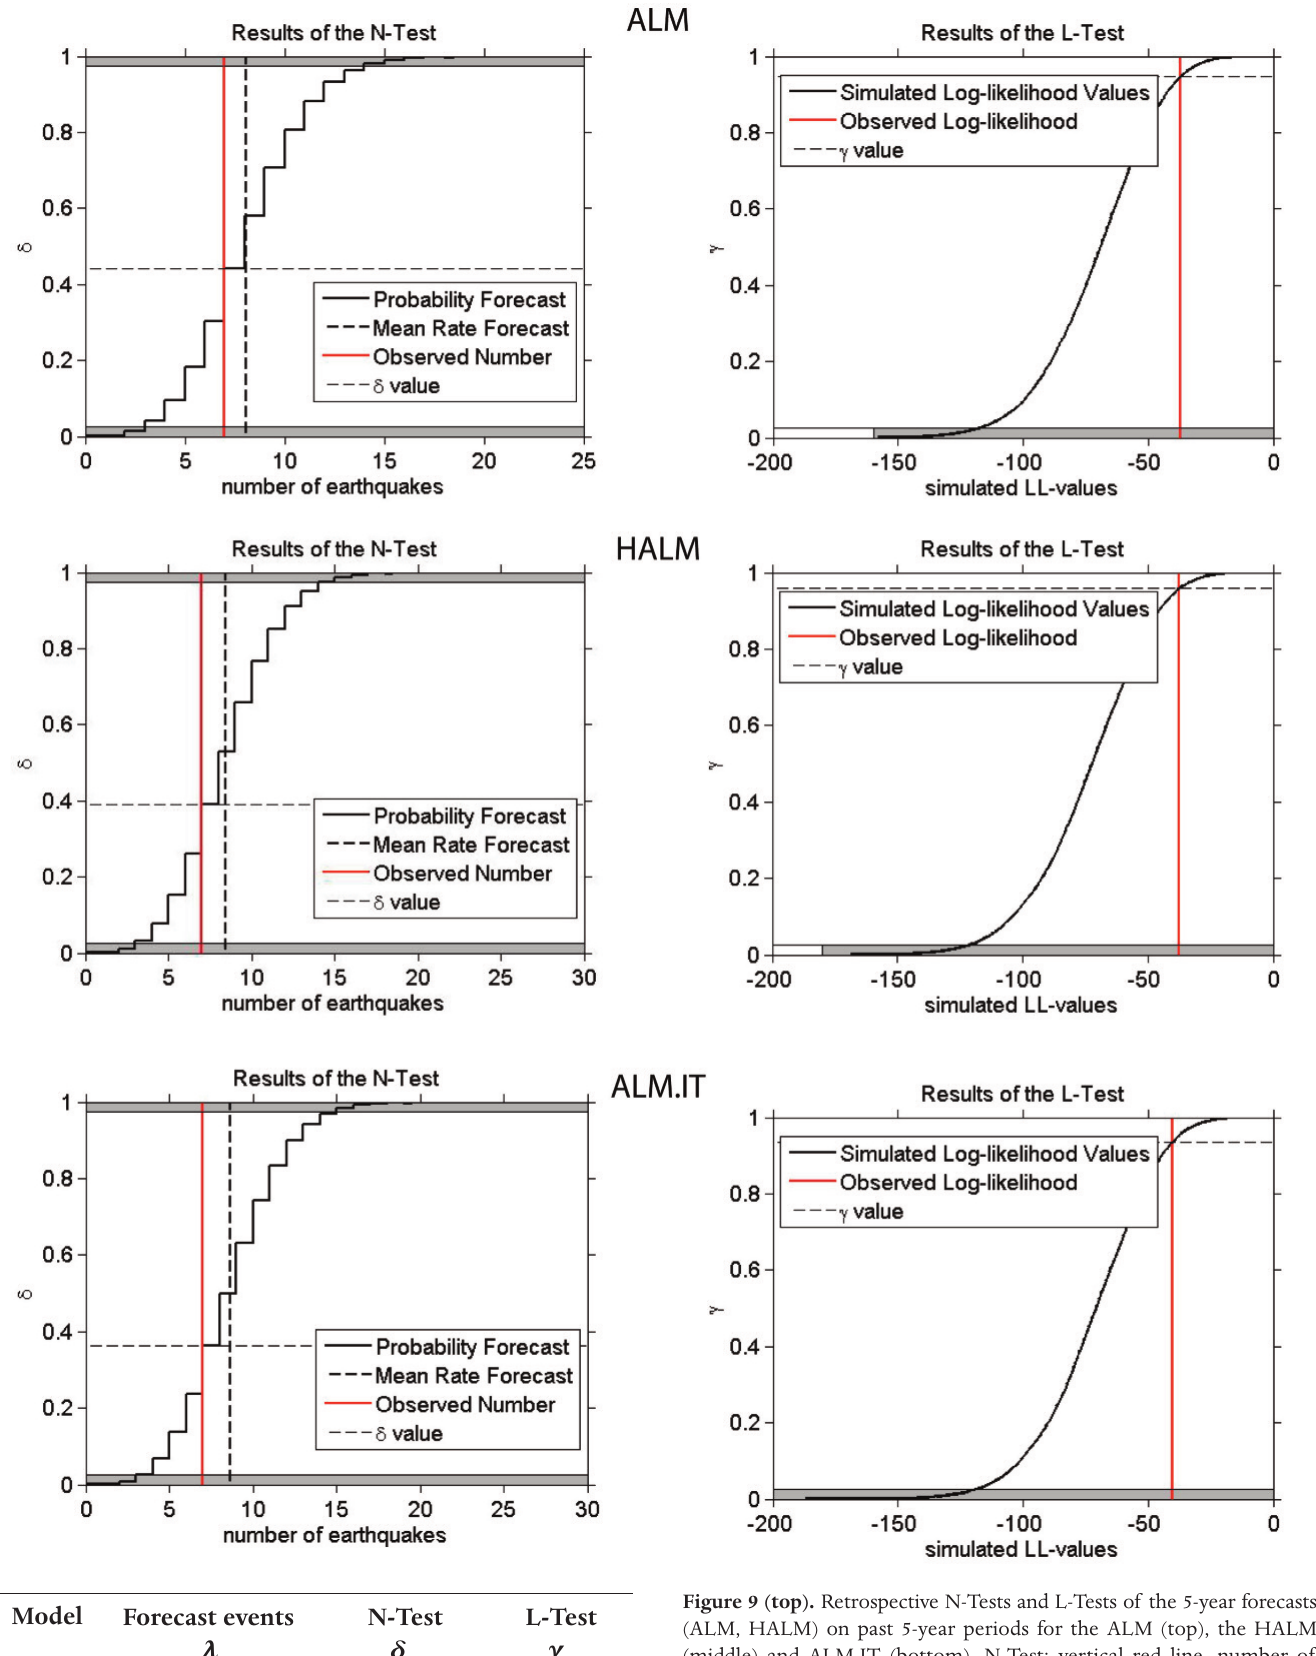
Figure 9 (top). Retrospective N-Tests and L-Tests of the 5-year forecasts (ALM, HALM) on past 5-year periods for the ALM (top), the HALM (middle) and ALM.IT (bottom). N-Test: vertical red line, number of observed events (7) in the 5-year target period (2002-2006); L-Test: the c values were calculated based on 10,000 simulations of log-likelihood values consistent with each model. Table 2 (left). Total number of forecast events and results of retrospective N-Test and L-Test for the three submitted